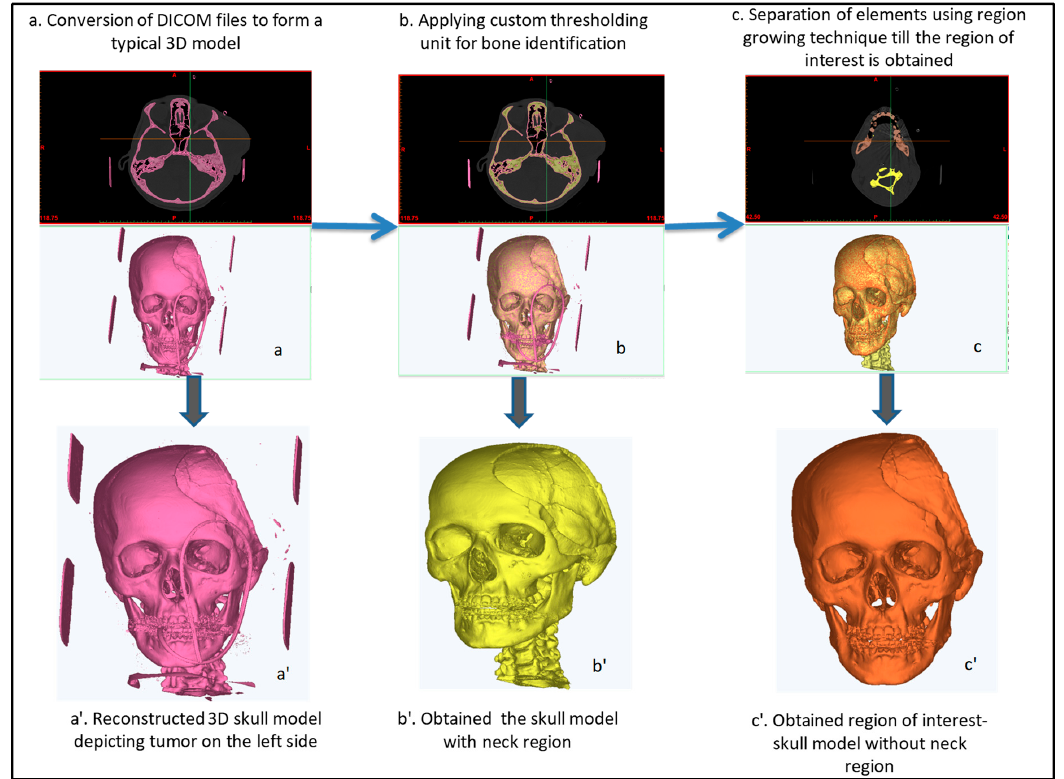
Figure 2. Image processing stages in Mimics ® : ( a ) Coversion of DICOM files; ( a’ ) Reconstructed 3D skull model; ( b ) Bone identification; ( b’ ) Skull model with neck region; ( c ) Application of region growing technique; ( c’ ) Obtaining region of interest.